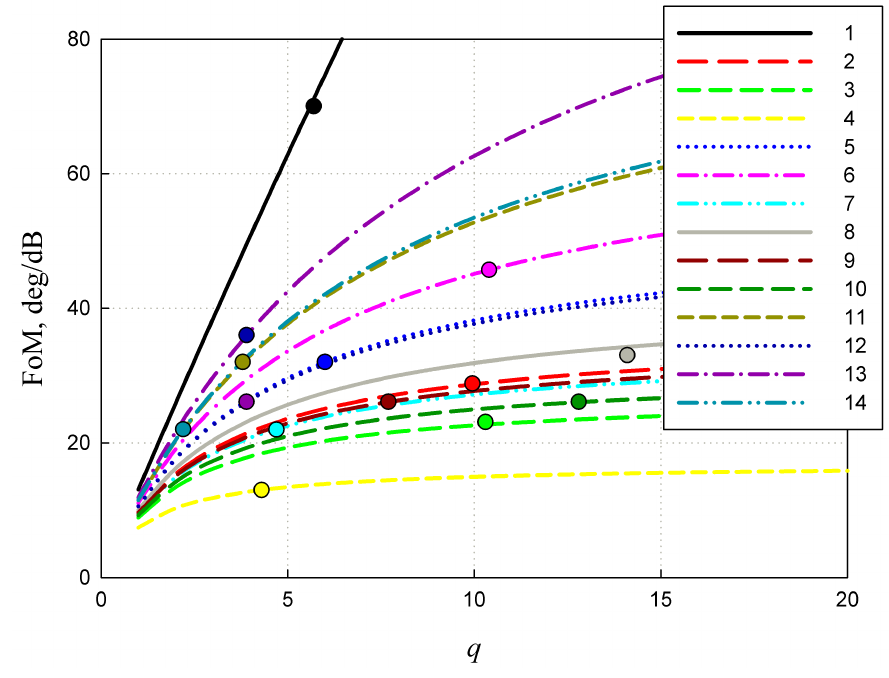
Figure 5. Figure of merit of phase-shifter versus figure of merit of capacitor or line.